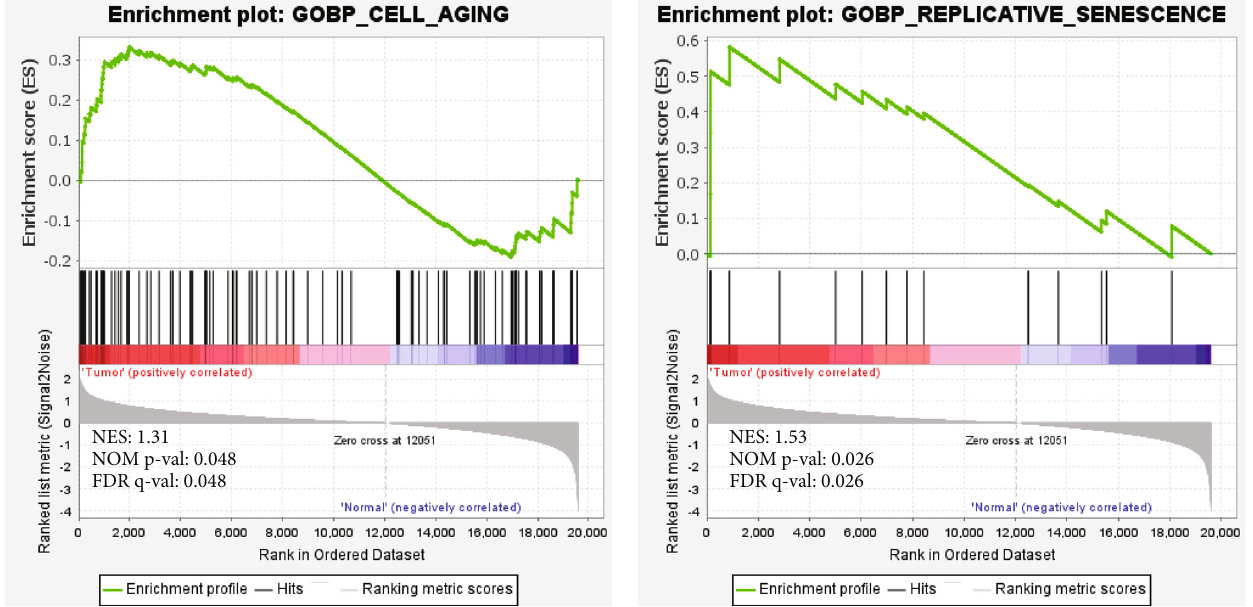
Figure 1: Gene set enrichment analysis of GO_CELL_AGING and GOBP_REPLICATIVE_SENESCENCE between tumor samples and normal samples.